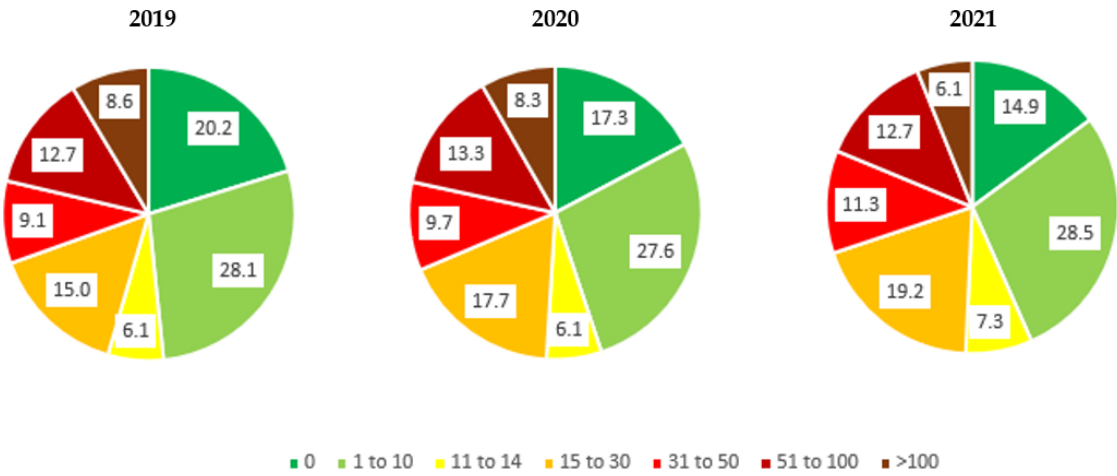
Figure 2. Storm overflow spill profiles for 2019, 2020 and 2021. Ranges are spill numbers. All water and sewerage company data combined.